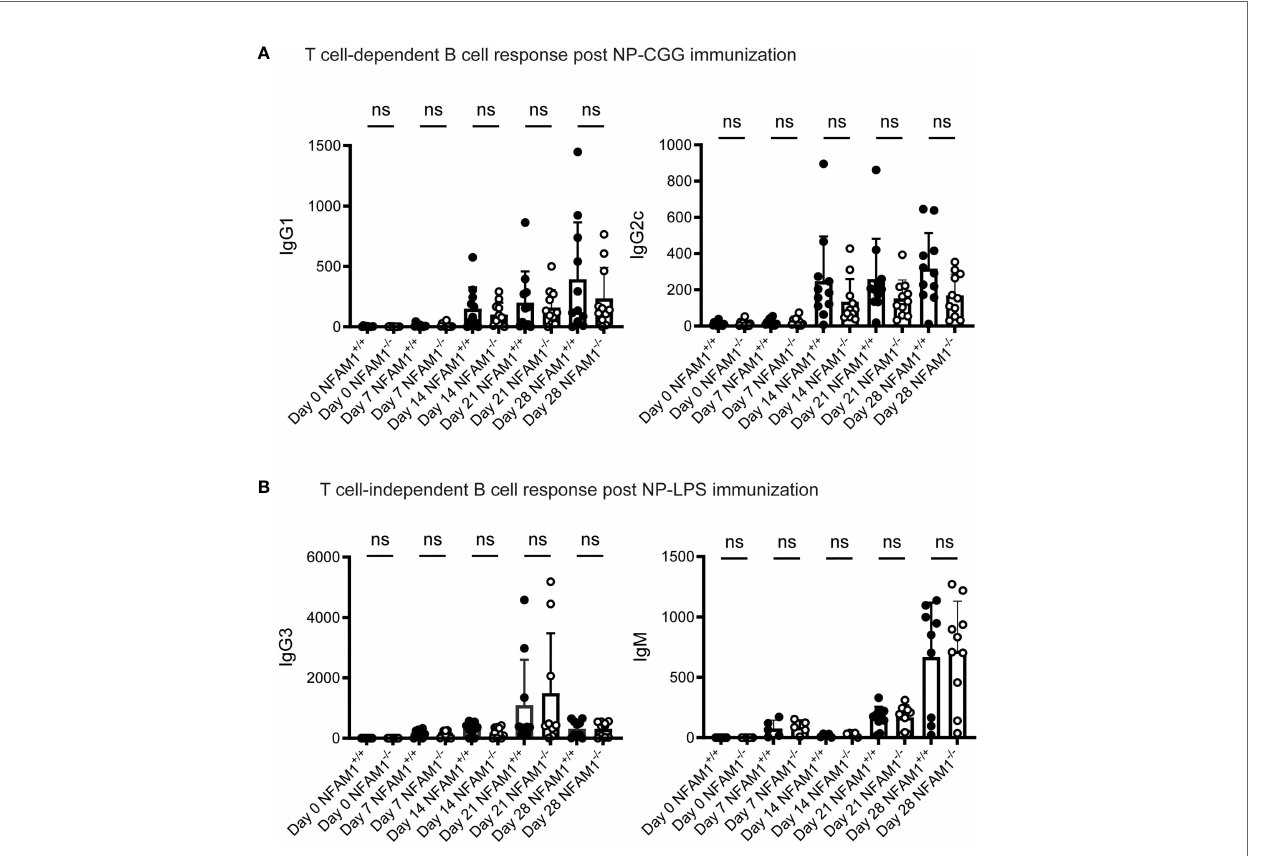
FIGURE 3 | NFAM1 -/- mice do not have signi fi cant defects in T cell-dependent or T cell-independent B cell responses. (A) Mice were immunized with NP-CGG on days 0 and 21. Shown is serum IgG1 and IgG2c. Data was combined from two independent experiments for a total of 11 NFAM1 +/+ and 11 NFAM1 -/- mice per timepoint. (B) Mice were immunized with NP and LPS on days 0 and 21. Shown is serum IgG3 and IgM. Data was combined from two independent experiments. Shown is mean of 6 NFAM1 +/+ mice and 6 NFAM1 -/- mice on days 0, 7 and 14 and mean of 10 NFAM1 +/+ and 10 NFAM1 -/- mice on days 21 and 28. NS indicates that the difference between NFAM1 +/+ and NFAM1 -/- samples is not statistically signi fi